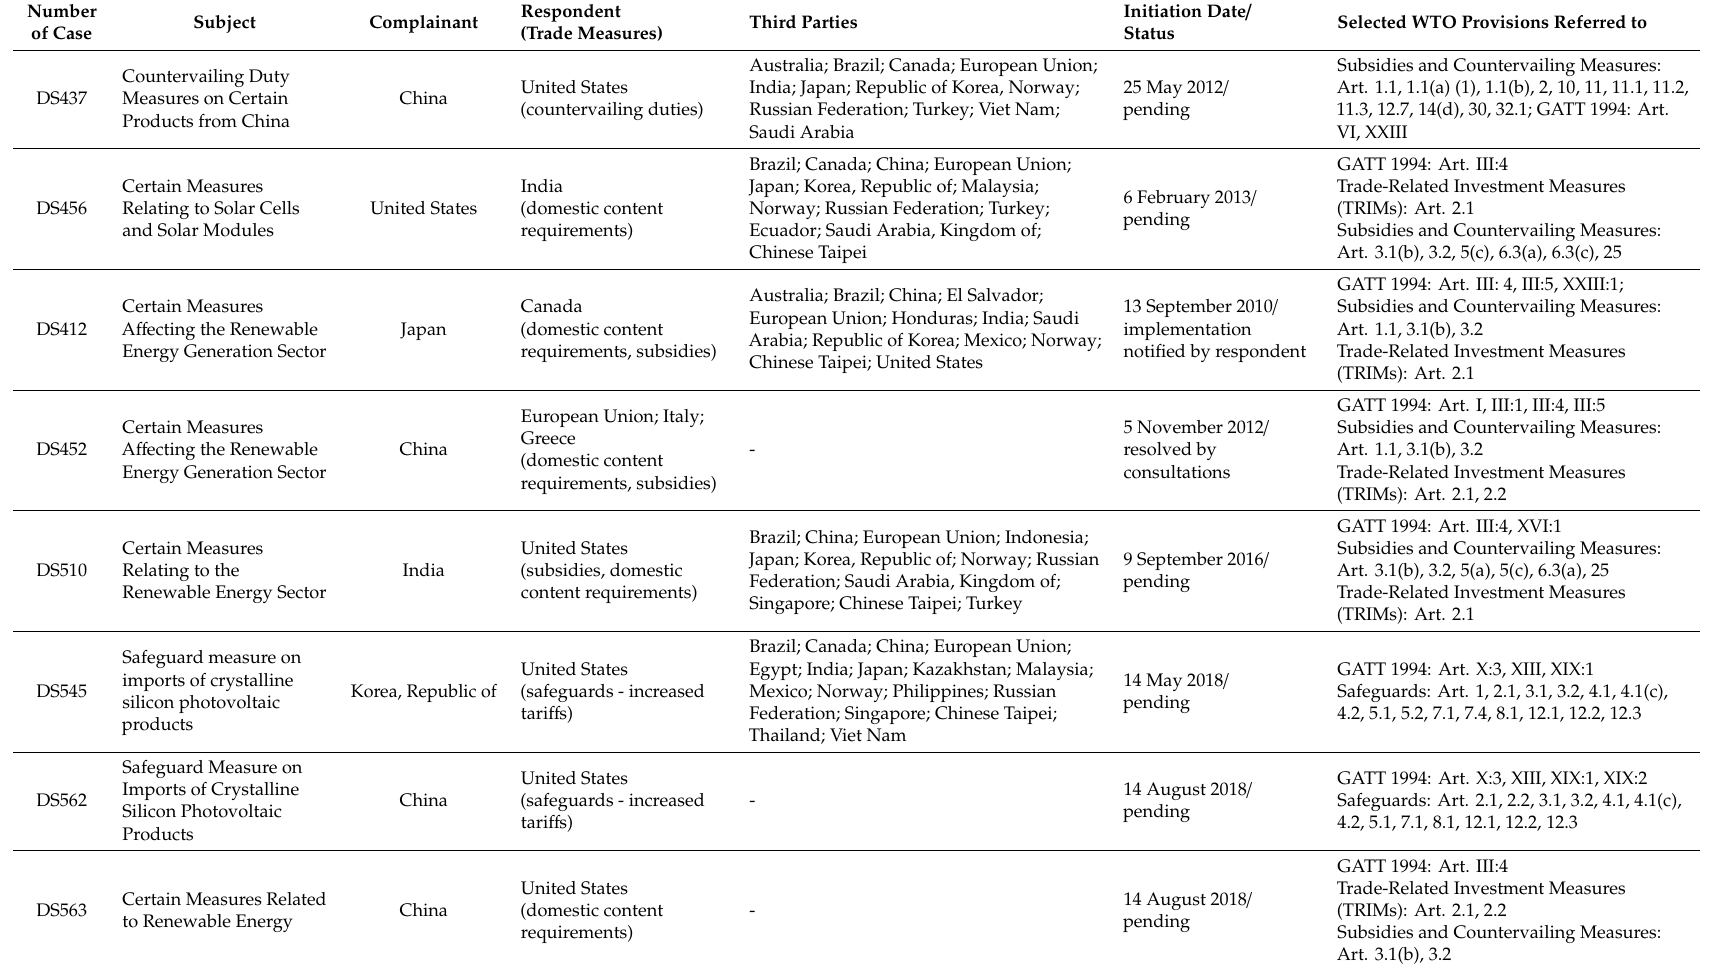
Table 1. World Trade Organization (WTO) trade disputes over solar